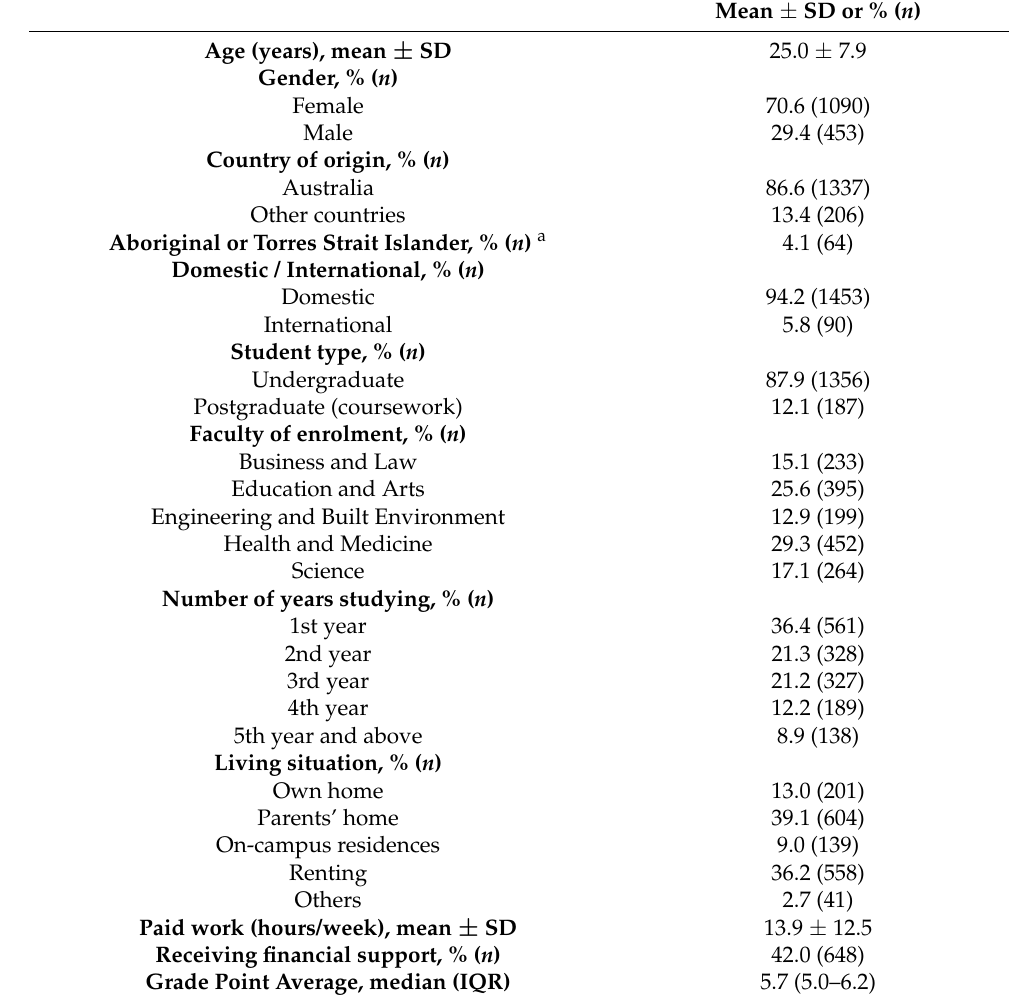
Table 1. Socio-demographic and student characteristics in a sample of Australian university students ( n = 1543).